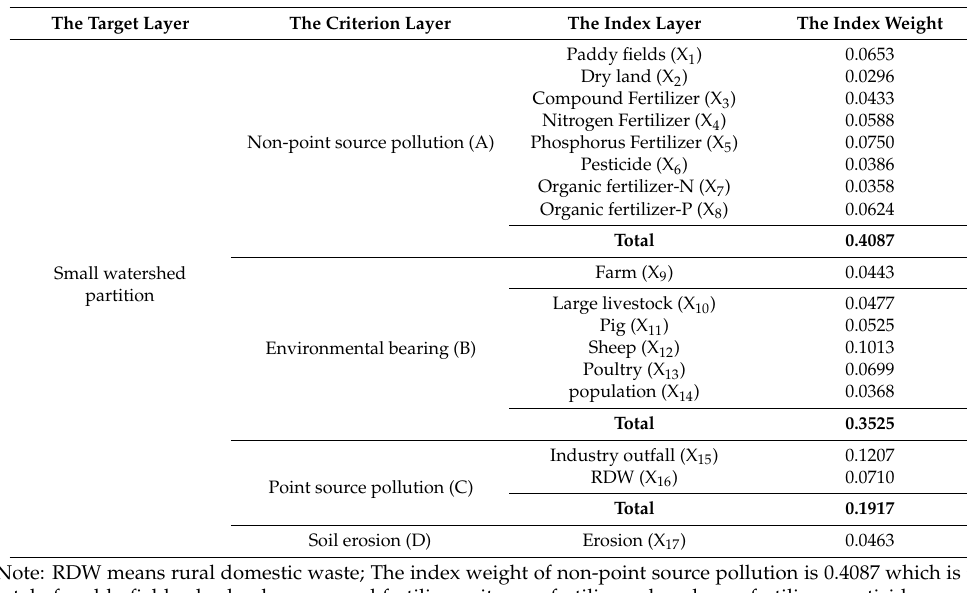
Table 2. The index system and weight of the small watershed classification upstream of the Dahuofang